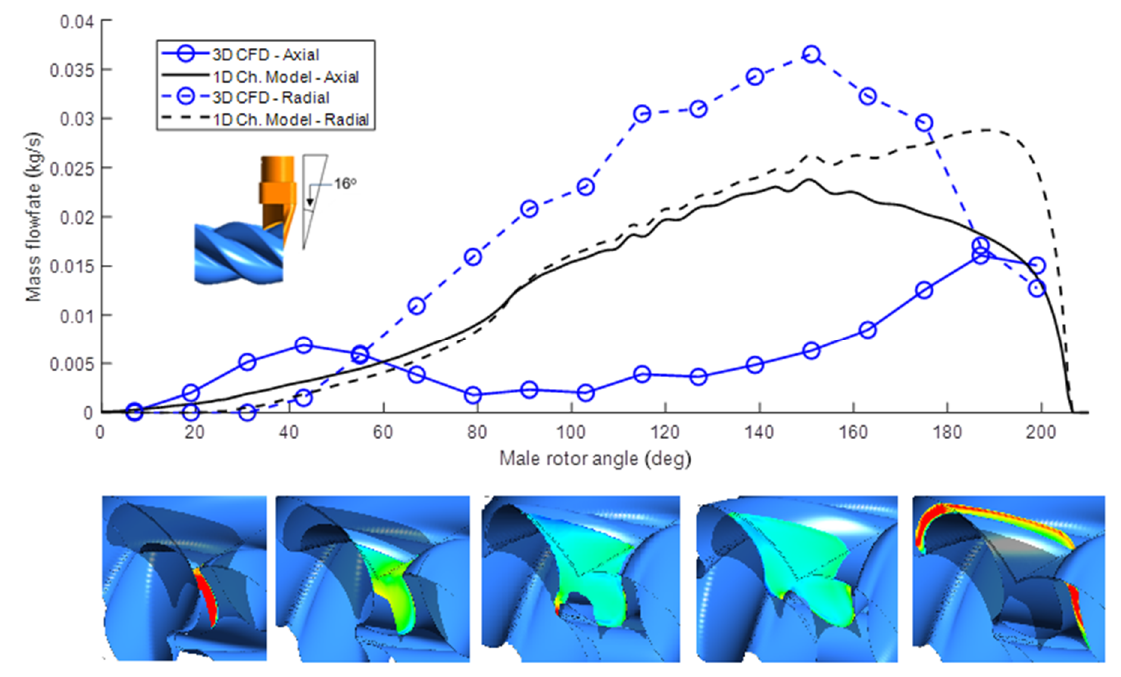
Figure 10. High-pressure flow characteristics for the GL51.2-M twin-screw expander (Pi = 2 bar and n = 4000 RPM).